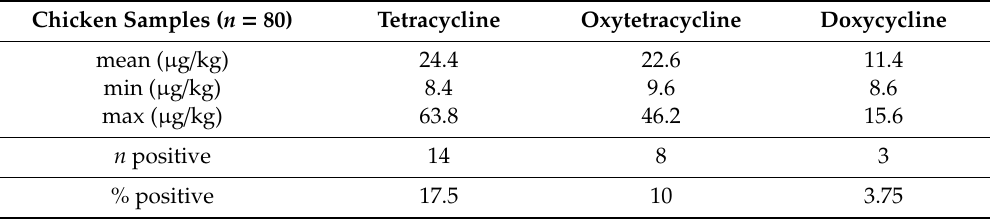
Table 6. Occurrence in the 80 chickens samples of tetracyclines.